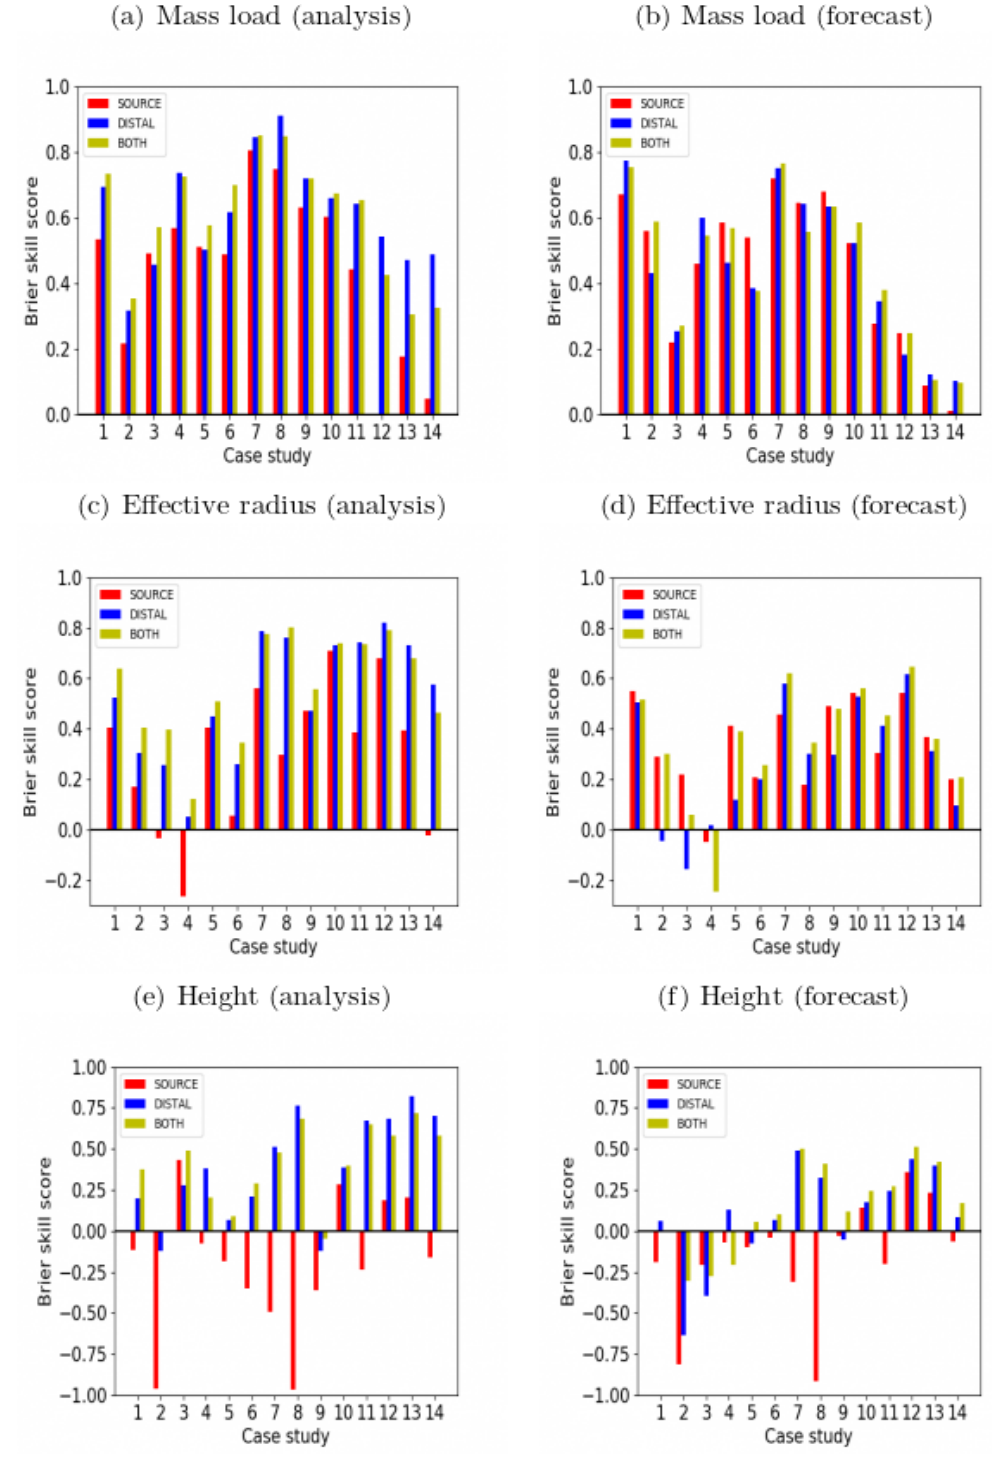
Figure 4. Brier skill scores obtained for 14 different eruption case studies using retrieval-based initialization and optimization. Other details are the same as in Figure 2.